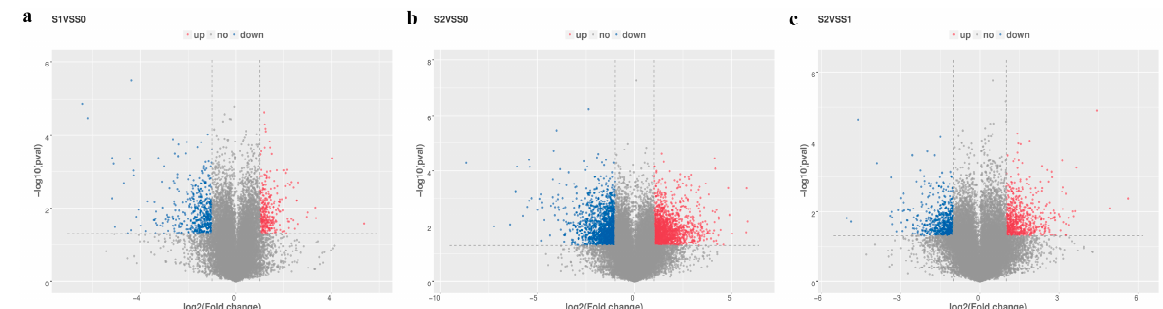
Data are represented as the mean ± standard deviation. ( n = 3).